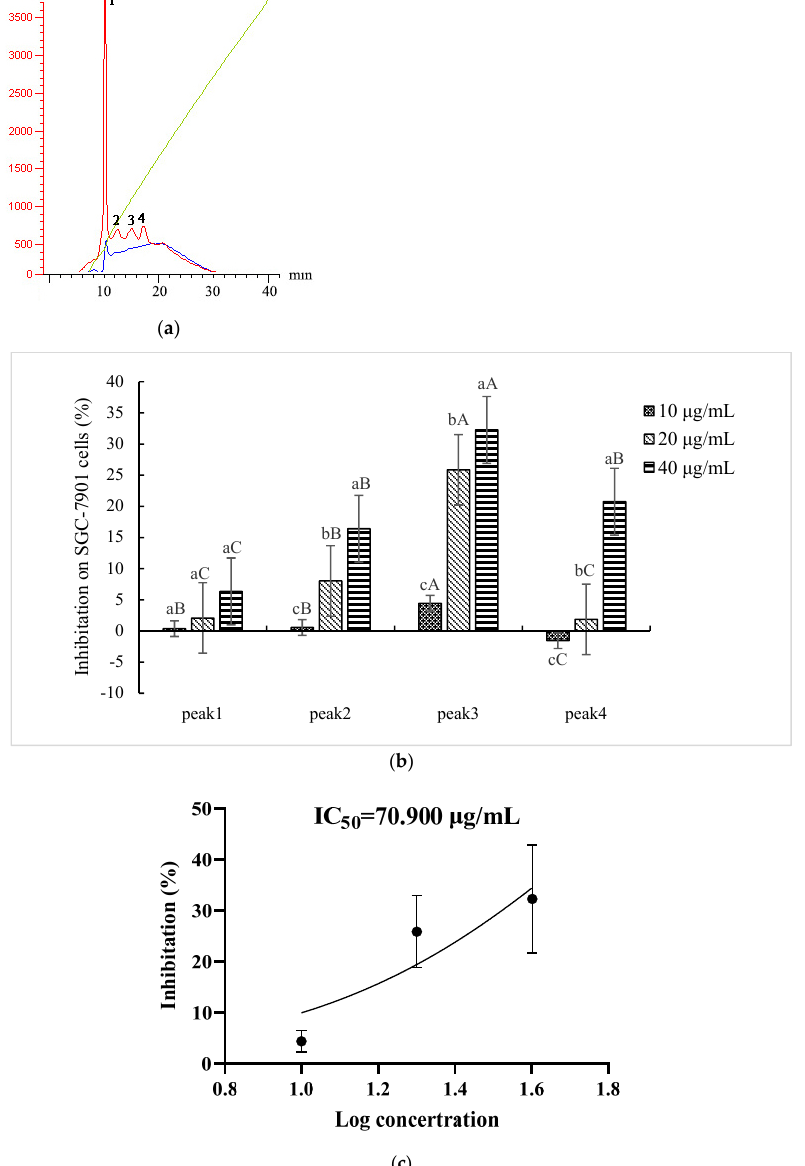
Figure 3. Inhibition effect of components separated by FPLC. ( a ) The elution curve of FPLC, linear electrical conductivity showed correctly linear elution. ( b ) Inhibitory rates of cell proliferation (SGC- 7901 cells) induced by Sect. II-3-1-4 that were separated by FPLC after 48 h treatment. a, b, c means p < 0.05; A, B, C means p < 0.01. ( c ) IC 50 curve fitting of Sect. II-3-3. Six fractions in Sect. II-3-3 (FPLC) were discriminated and eluted by RP-HPLC (Fig- ure 4a): peaks 1–6 were denoted as Sect. II-3-3-1-6, respectively. Each fraction (differential peak collection) was treated the same as above. Sect. II-3-3-2 (peak 2), Sect. II-3-3-3 (peak 3), and Sect. II-3-3-5 (peak 5) expressed inhibitory effects on the proliferation of SGC-7901. In particular, a dosage-dependent action manner was shown in Sect. II-3-3-2 and Sect. II- 3-3-5 (Figure 4b). Sect. II-3-3-5 had the highest inhibition effect at a high concentration treatment (30 μ g/mL), and its IC 50 value was 51.290 μ g/mL (Figure 4c). Therefore, Sect. II- 3-3-5 was collected to determine molecular weight and amino acid sequence. Although the raw product (Sect. II, isolated by ultrafiltration) originating from the hemolymph of A. chinensis had a relatively high quantity, the component(s) with anti- cancer activity was had a low yield rate (Table 2). The final yield rate of active peptide(s) was 0.020% compared to peptides/proteins in the raw product (Sect. II). Compared to the last step, the yield rate for each dissection operation increased along with separation and purification, step by step. Along with the purification and enrichment of active peptide(s), the IC 50 value of isolated fractions decreased sequentially.